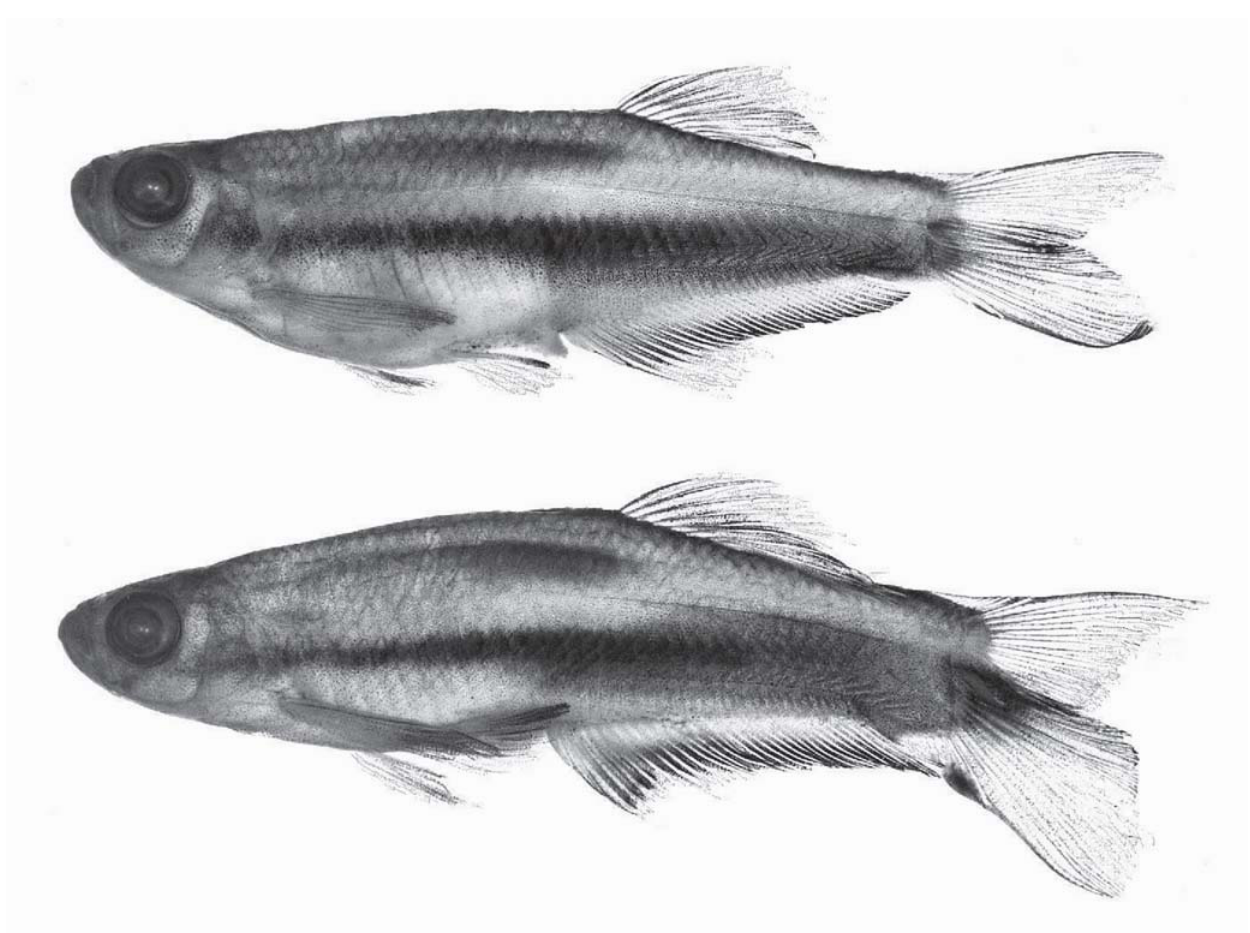
Fig. 52. Mimagoniates lateralis , young adults female above, male below. USNM 226468, 31.0 and 32.6 mm SL respectively, Paraná State, road between Paranaguá and Matinhos, at km